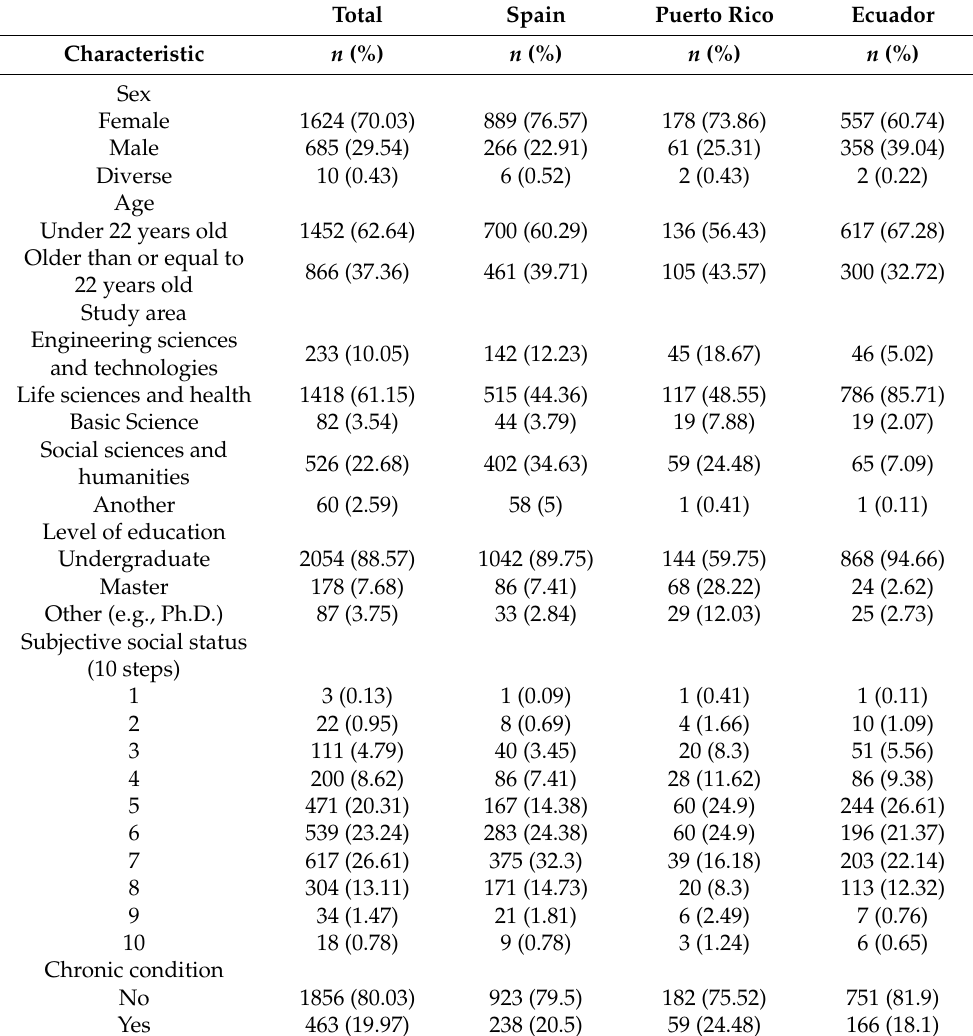
Table 1. Sociodemographic characteristics of participating university students from Spain, Puerto Rico, and Ecuador in 2020 ( n = 2318).